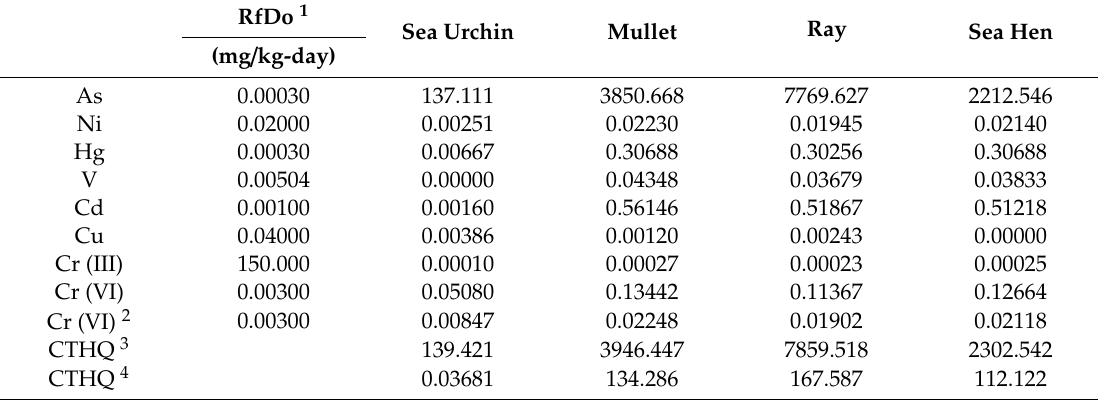
Table 9. Estimated target hazard quotient (THQ) and cumulative target hazard quotient (CTHQ) of inorganic elements for the inhabitants of the study area through the consumption of